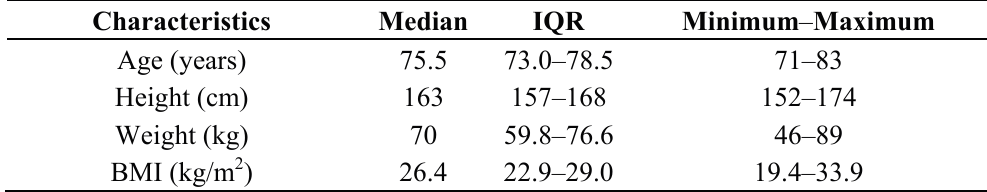
Table 1. Baseline characteristics of all participants ( n = 26